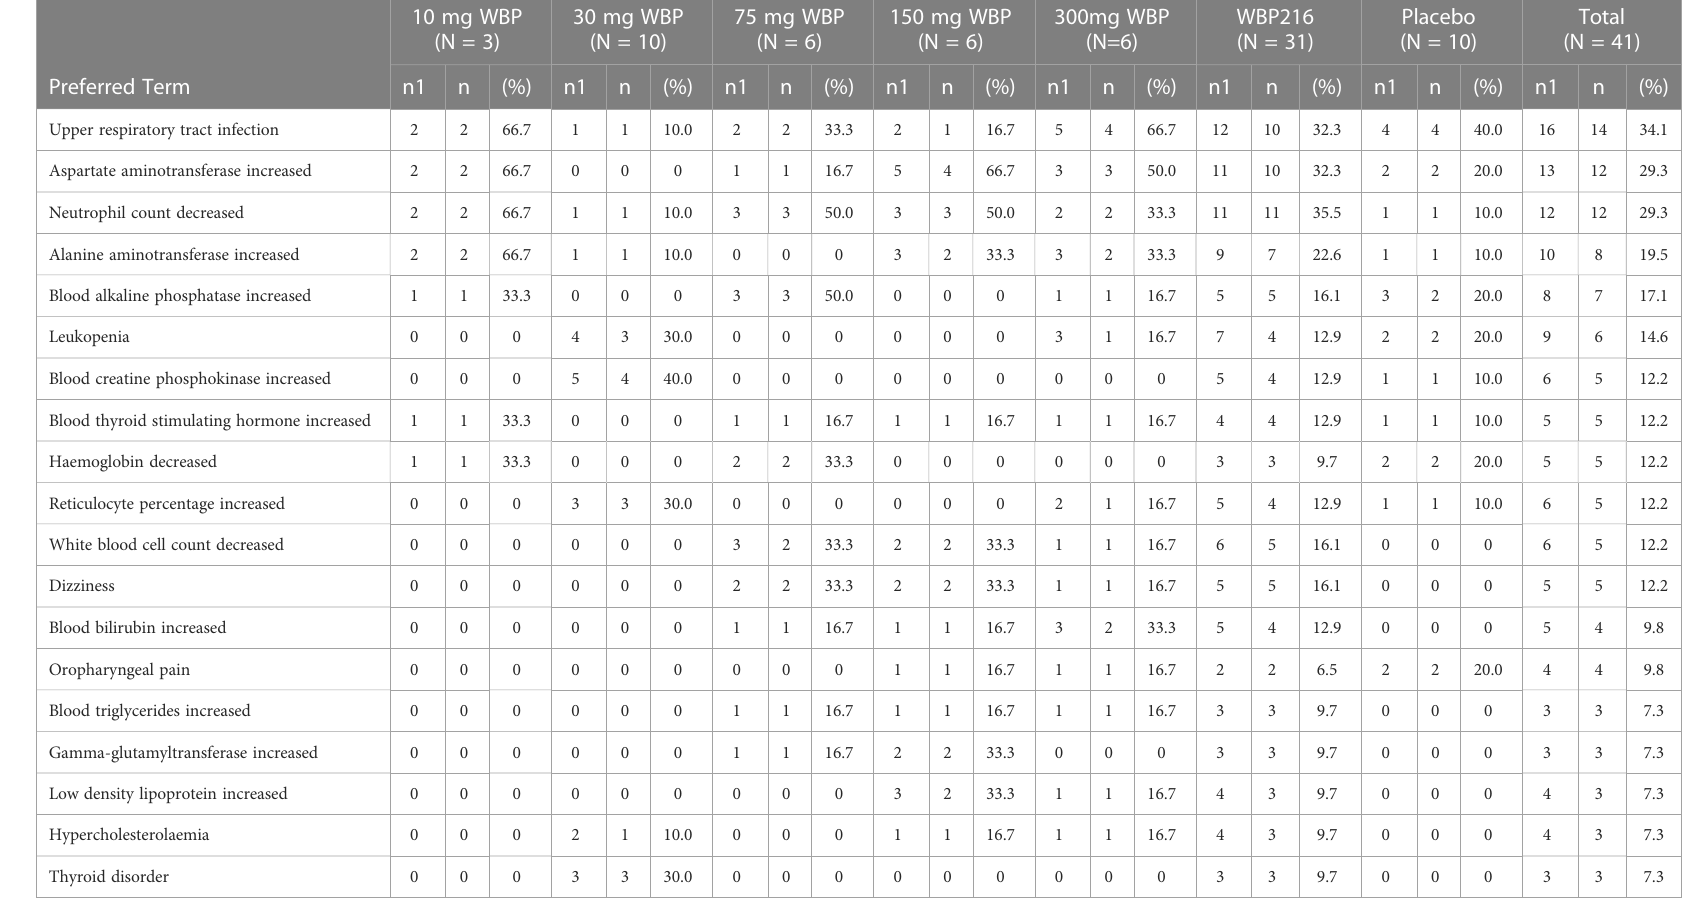
TABLE 2 Treatment-emergent adverse events (with total incidence ≥ 5.0%): Safety analysis